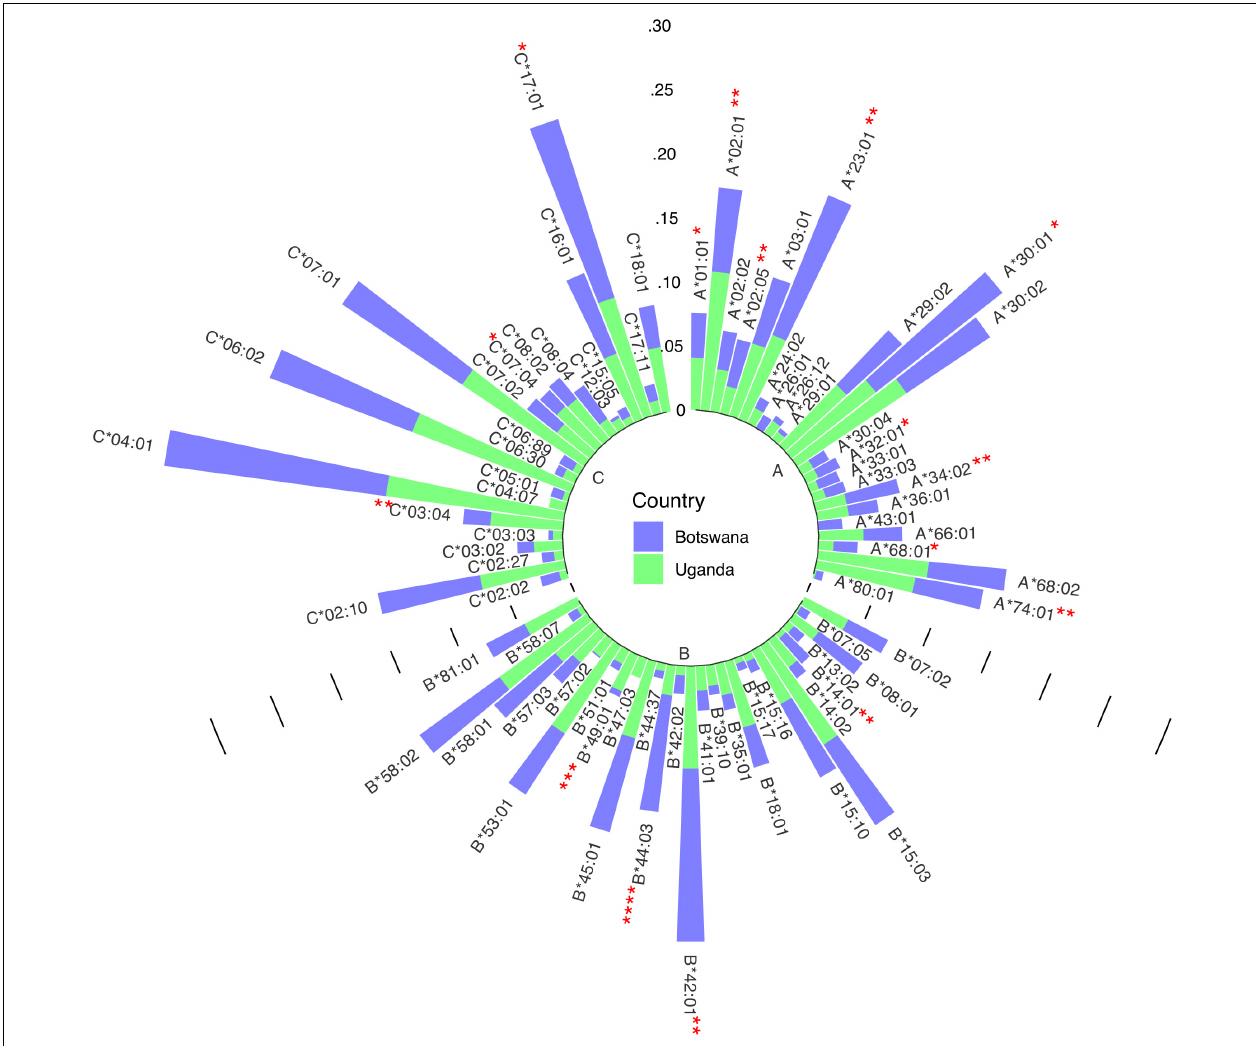
FIGURE 1 | Circular bar plot of HLA class I distribution in Uganda and Botswana. Each bar represents a class I HLA allele. The heights represent the relative frequency of each allele per country and significantly different alleles are shown with asterisks.